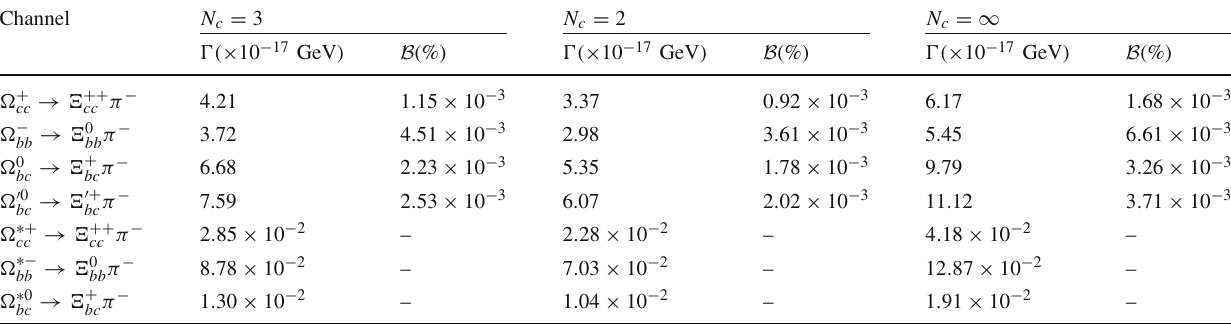
Table 7 Numerical results of decay width and branching fraction in doubly heavy baryon nonleptonic decays using F( q 2 ) when N c = 3 , 2 , ∞